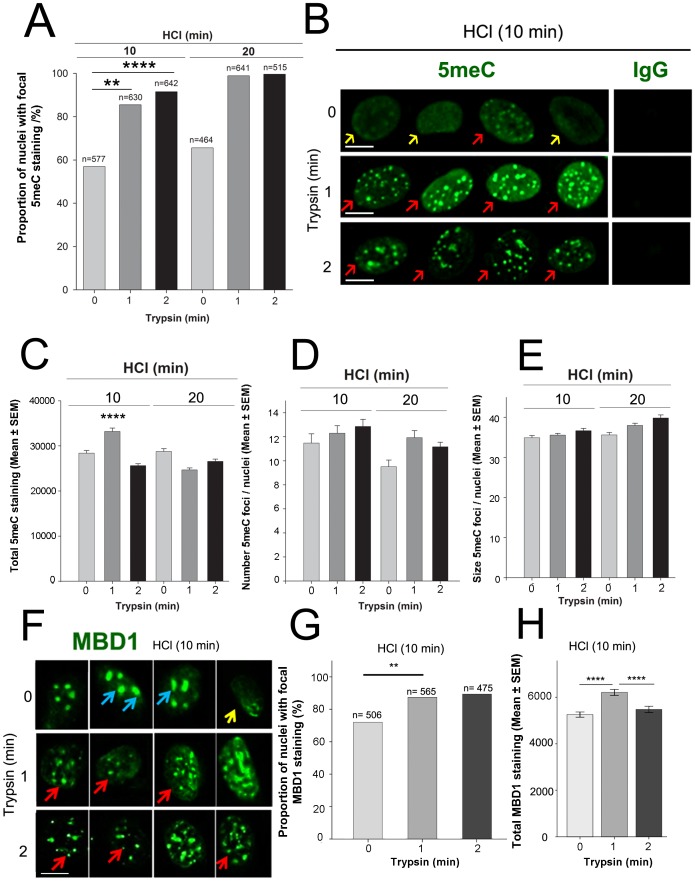
Staining pattern of 5meC and MBD1 antigens after epitope retrieval acid or acid plus trypsin treatment of confluent MEFs.Fixed and permeabilized MEFs were treated with HCl for 10 or 20A The proportion of nuclei (%) with focal 5meC staining (n, number of nuclei analysed). HCl (p<0.01) and trypsin (p<0.01) treatments revealed an increase in the focal staining of nuclear 5meC. 20 min HCl caused no further increase (p>0.05) after trypsin. B Typical examples of focal and diffuse staining of 5meC staining within the nuclei, yellow and red arrows indicate predominantly diffuse and focal staining, respectively. Non-immune IgG control staining is also shown. C The total level of 5meC staining of treatments shown in A. The results are the mean ± SEM of arbitrary units of optical density increased (**** p<0.0001). D The average number of 5meC foci per cell in A. E The average size (cross-sectional area) of 5meC foci in cells in A. F Representative images of MBD1 staining after 10 min HCl and trypsin 0, 1 or 2 min. Blue and red arrows indicate large and small foci of MBD1, respectively, and yellow arrow shows diffuse staining of MBD1. G The proportion of nuclei with focal MBD1 staining increased after 1 min trypsin (p<0.01). H The total level of MBD1 staining (arbitrary units of optical density) increased after 10 min HCl and 1 min trypsin (p<0.0001) Mean +/− standard mean of error. Results are from three independent replicates. ** p<0.01 and **** p<0.0001. Scale bar 10 µm. If not shown on individual graphs, the relevant statistical outcomes are stated within the results text.